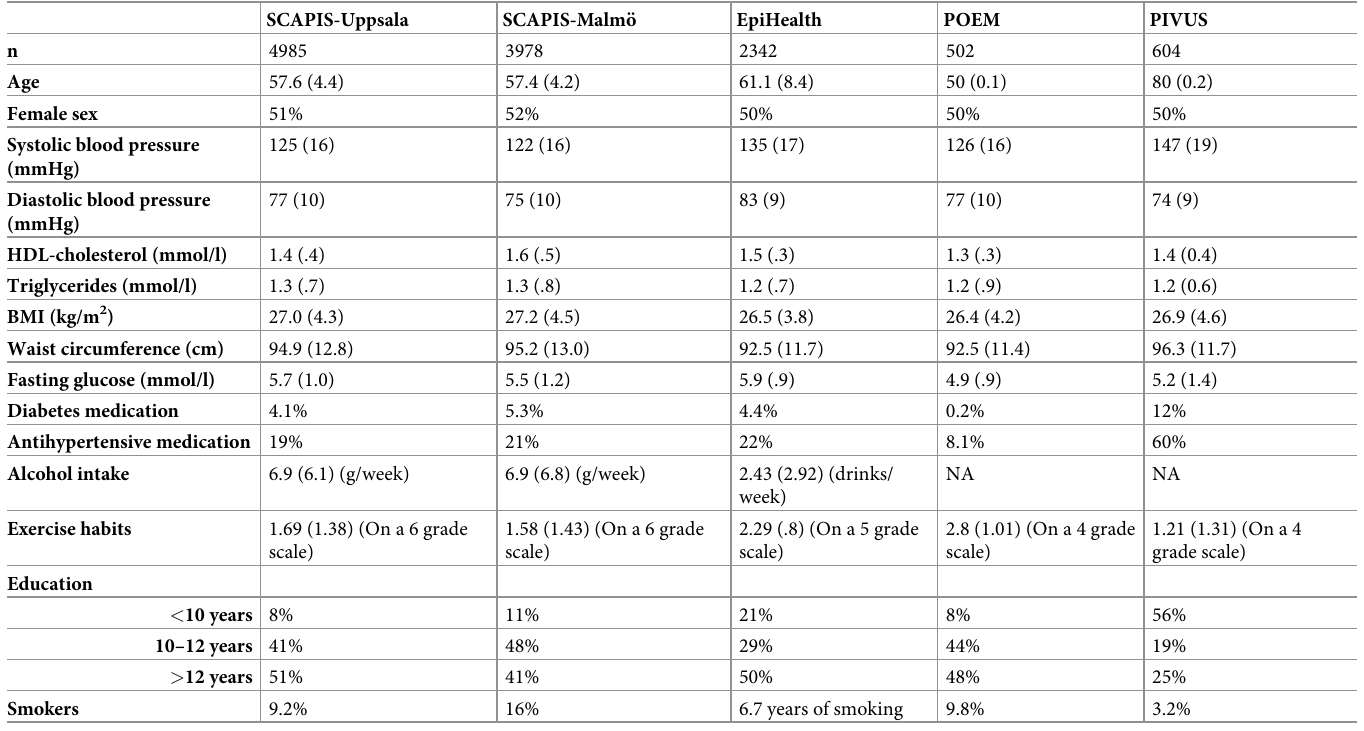
Table 1. Basic characteristics of the samples. Means and (SD) are given, or proportions in